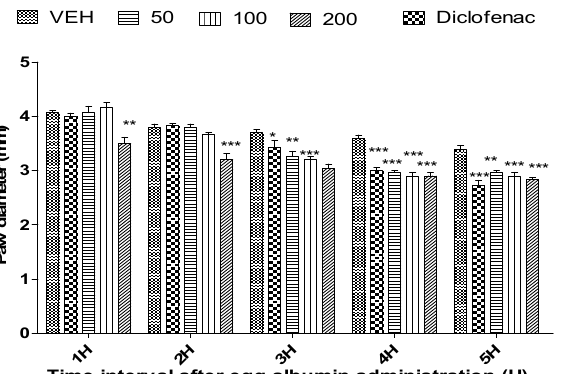
Figure 5. Effect of “Ruby Red” grapefruit ( C. paradisi ) fresh peel essential oil on egg albumin-induced rat paw oedema. Results are expressed as Mean ± SEM. VEH, ECH and ASA represent vehicle (5% Tween 80), Ruby peel essential oil (FSPG) and diclofenac, respectively. * p < 0.05, ** p < 0.01 and *** p < 0.001, statistically different from negative control group (ANOVA, Dunnett’s).